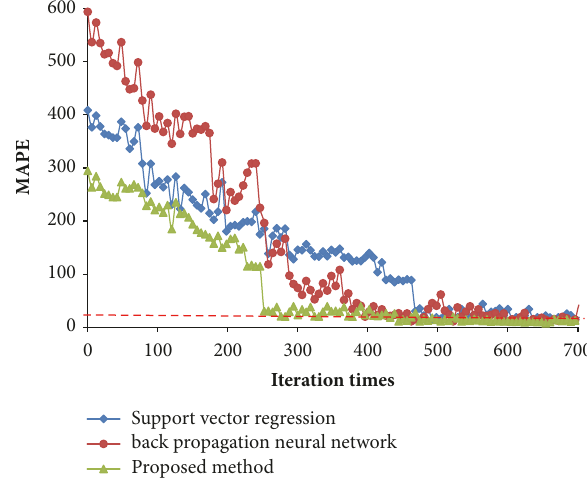
Figure 5: Convergence of upper-phase model based on different methods.